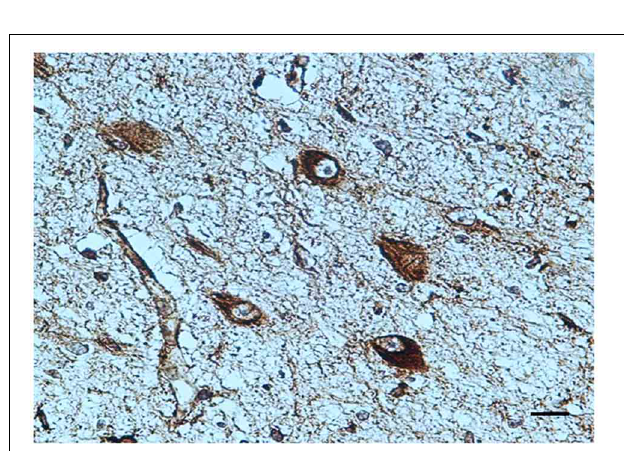
cells (interneurons and astrocytes). The large neurons can be subdivided in two groups: a compact subnucleus and a dissipatus subnucleus. Klüver Barrera staining. Scale bar = 10 µ m. csn, compact subnucleus; dsn, dissipatus subnucleus; ml, medial lemniscus; scpd, decussation of the superior cerebellar peduncles.